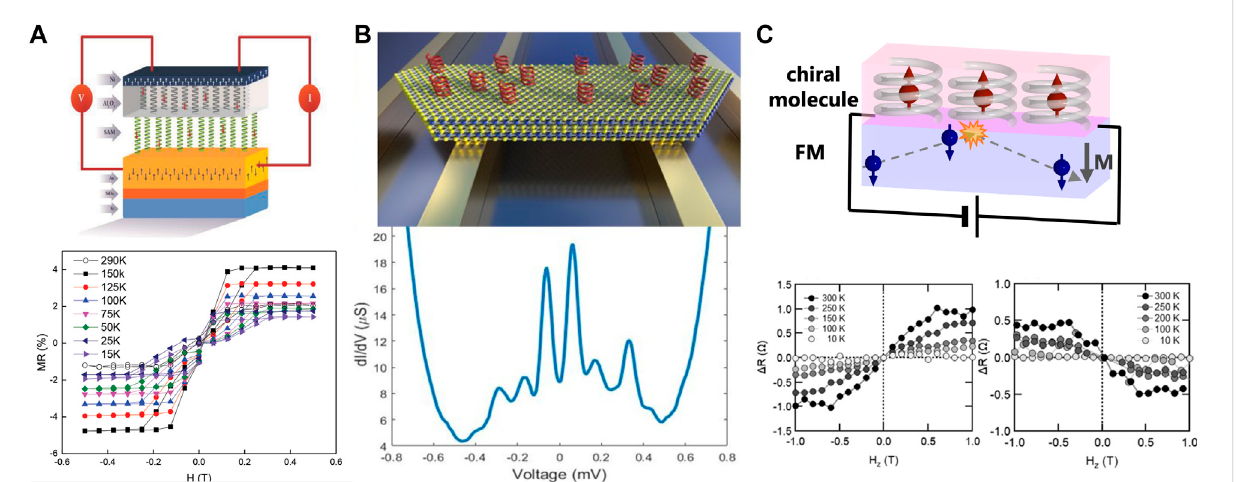
FIGURE 5 Molecular chirality-induced spin functionalities. (A) Chirality-dependent current perpendicular to the plane magnetoresistance against the external perpendicular magnetic fi eld. Charge current fl ows in the chiral molecules in [94]. (B) Magnetic impurity-like state in superconductor induced by chiral molecules in [101]. (C) Chirality-dependent current-in-plane magnetoresistance in ferromagnetic metal/chiral molecule bilayer without bias charge current in the chiral molecule in [104]. Magnetoresistance decrease with decreasing the measurement